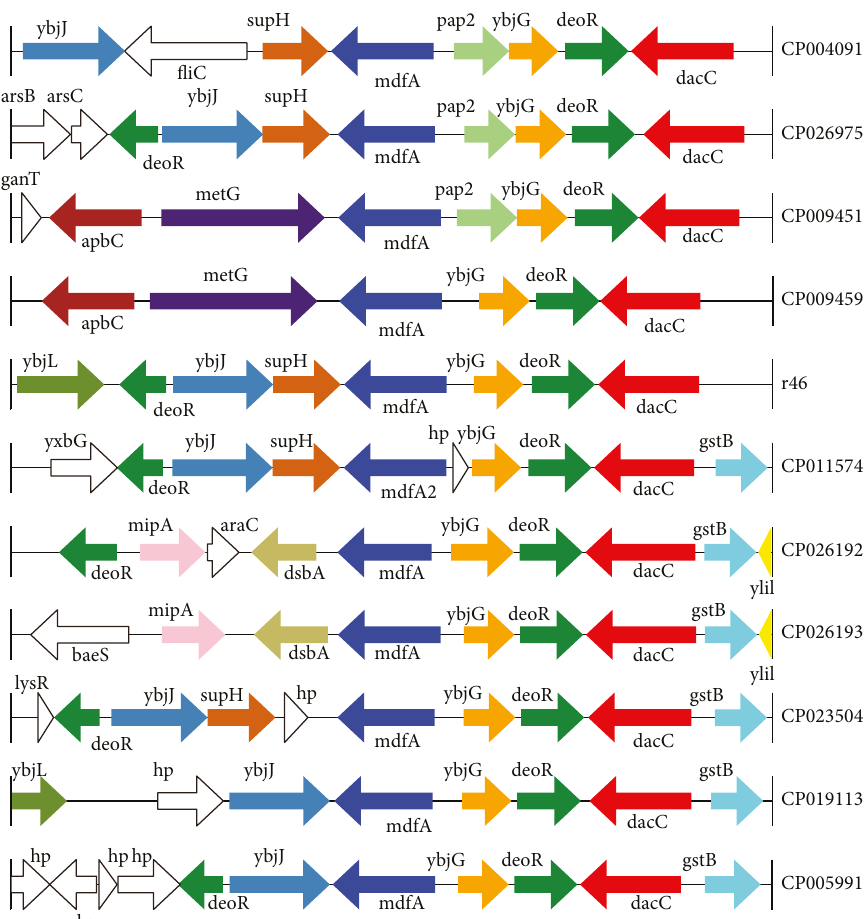
Figure 2: Comparative analysis of the mdfA-related regions of 11 representatives from 980 sequences. The representative sequences were derived from the following bacteria: CP004091 ( C. sakazakii SP291 CP004091), CP026975 ( E. cloacae complex bacterium FDAARGOS_77 CP026975), CP009451 ( C. neteri SSMD04 CP009451), CP009459 ( C. neteri ND14a CP009459), CP011574 ( K. aerogenes CAV1320 CP011574), CP026192 (Enterobacteriaceae bacterium ENNIH2 CP026192), CP026193 (Enterobacteriaceae bacterium ENNIH1 CP026193),